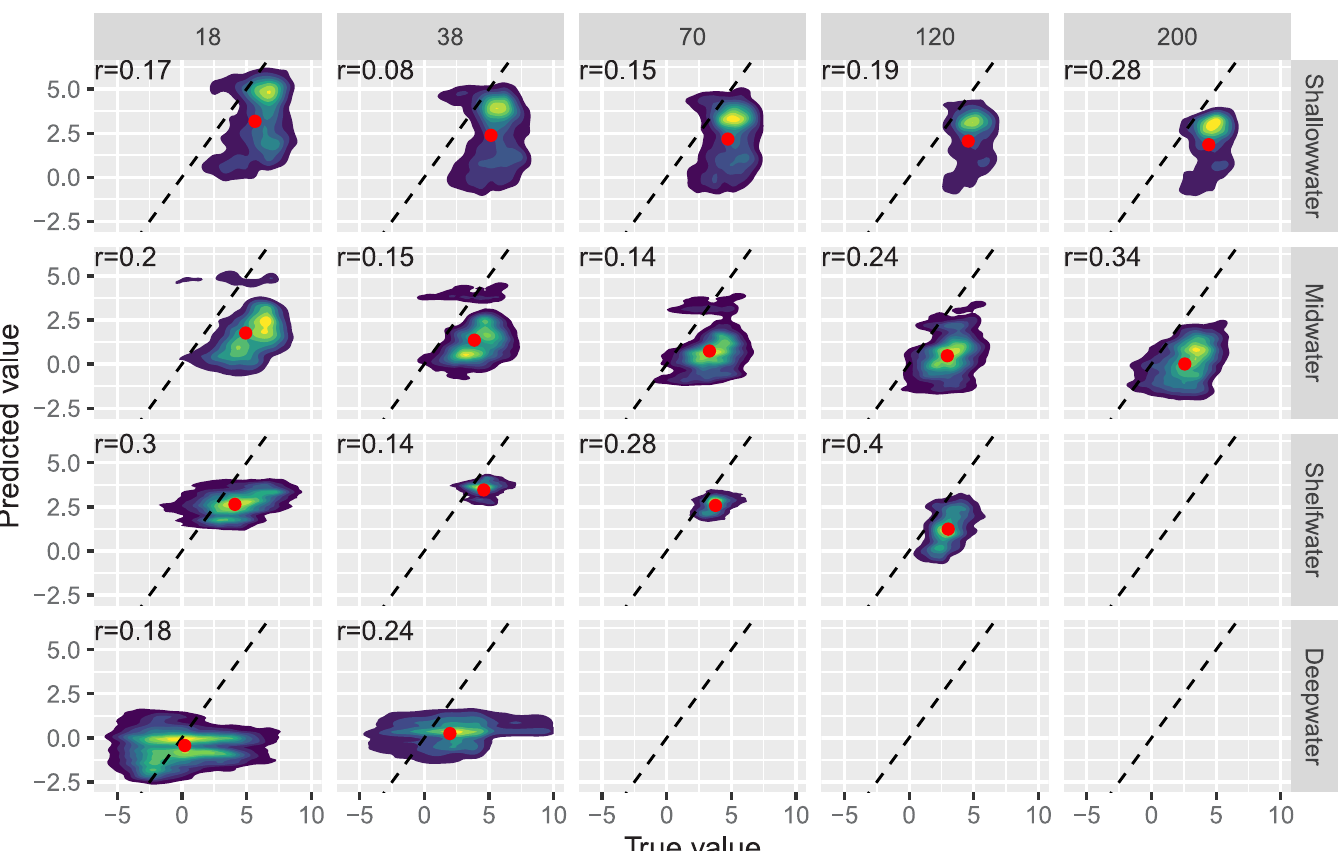
Fig 4. Observed vs. true values in the test set. Density surface plots for the relationship between predicted and true (observed) log NASC values in 584,917 observations from the withheld 2015 test set and the full model, by depth bin (panel rows) and sonar frequency in kHz (panel columns). Yellow represents high point density, and dark blue represents low point density. A dashed one-to-one line is shown in every panel, the mean values of true and predicted log NASC are shown as red dots. Red dots far from the dashed line indicate bias in the mean predictions. Pearson correlation coefficients are printed in the upper left of each panel.